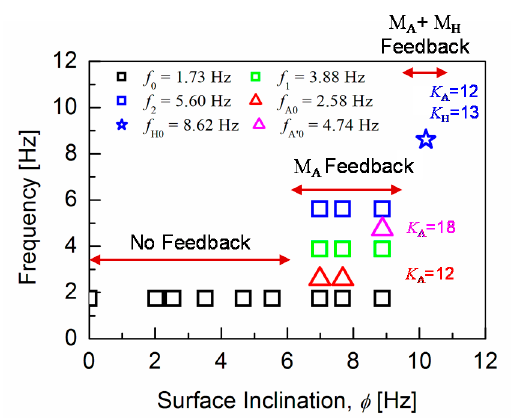
Figure 11. Contributing frequencies as extracted from the frequency-response analysis of the angular- pitch velocity as a function of surface inclination φ . angular-pitch velocity as a function of surface inclination φ